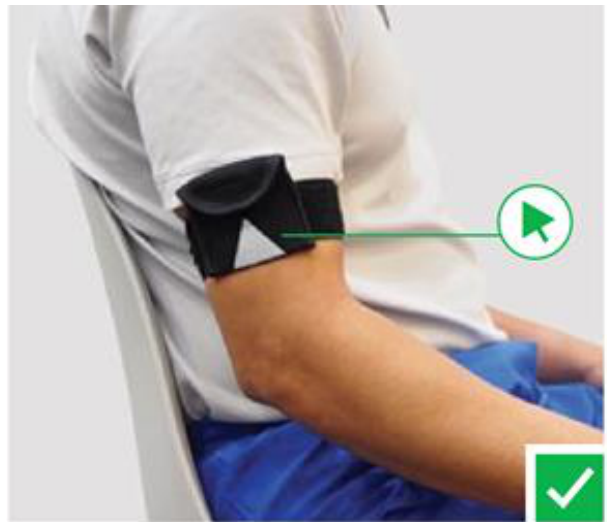
Figure 1 . The telerehabilitation kit. Items: (1) iPad; (2) iPad Stand; (3) Limb Sensor; (4) Limb Sensor case; (5) Neck Sensor; (6) iPad charger kit; (7) Sensor charger kit; (8) Resistance tubes: (a) Yellow (Easy), (b) Red (Moderate), (c) Green (Intermediate), (d) Blue (Difficult). The patient donned one sensor for the upper limb. This sensor was strapped to the mid-portion of the proximal left/right arm (Figure 2). The final set up is shown in Figure 3.